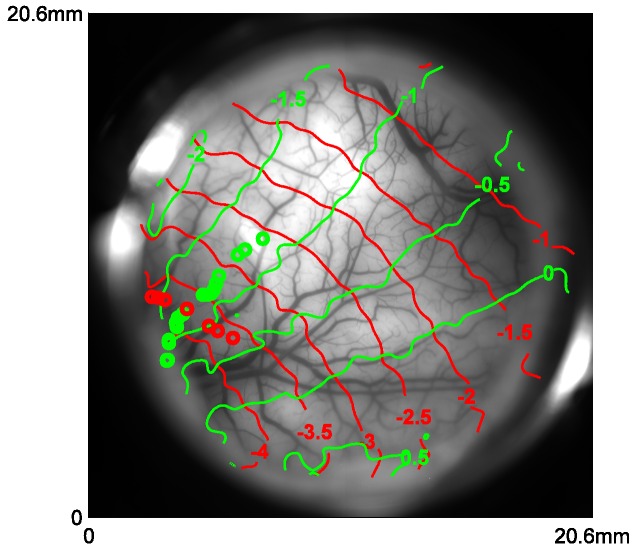
Retinotopic map obtained with VSD imaging and corresponding cortical locations of the centers of Gabor patches used in position tuning.Red and green curves represent the coordinates of X and Y in visual field in one monkey, respectively. Red and green circles represent the corresponding locations of the Gabors in vertical and horizontal trajectories, respectively.